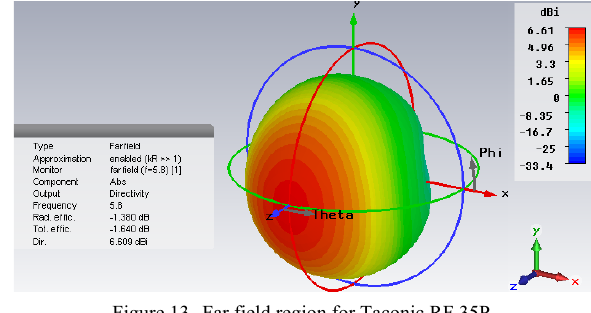
Figure 10. Far field region for Arlon Di 522.